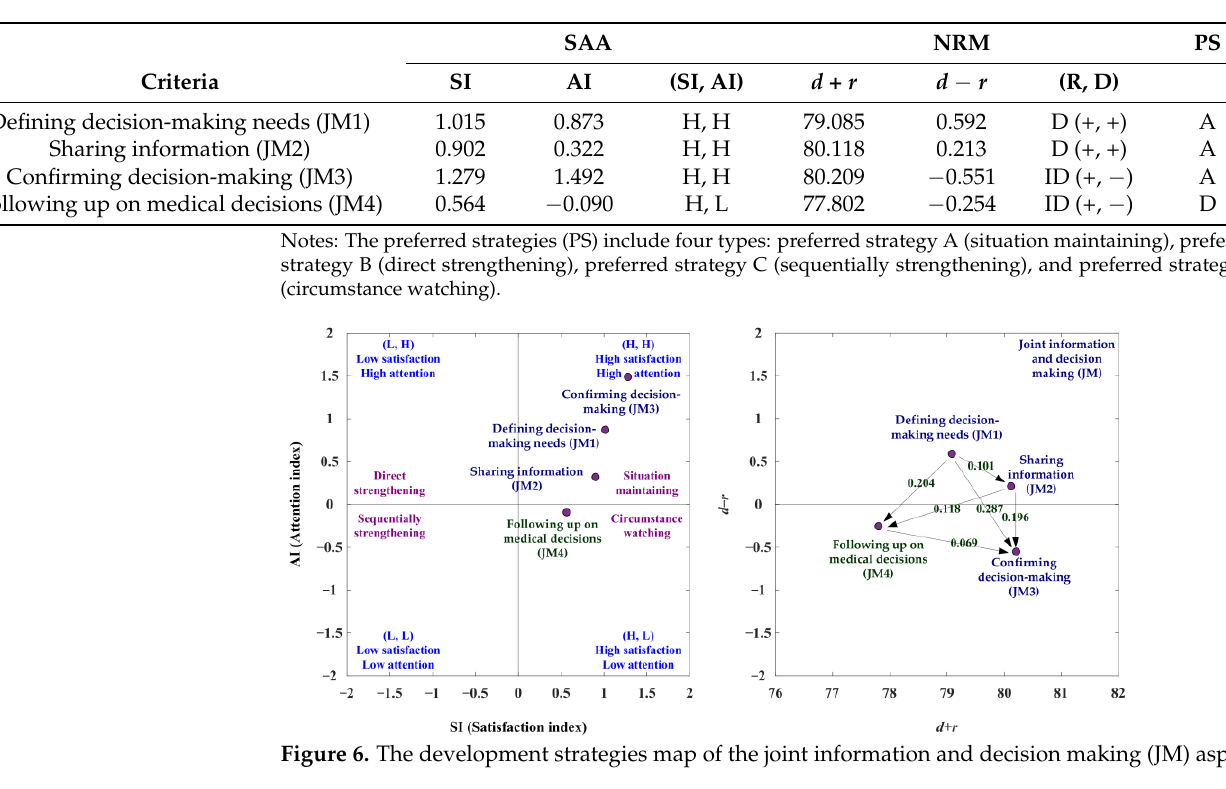
Table 15. The development strategies of joint information and decision making (JM) aspect.